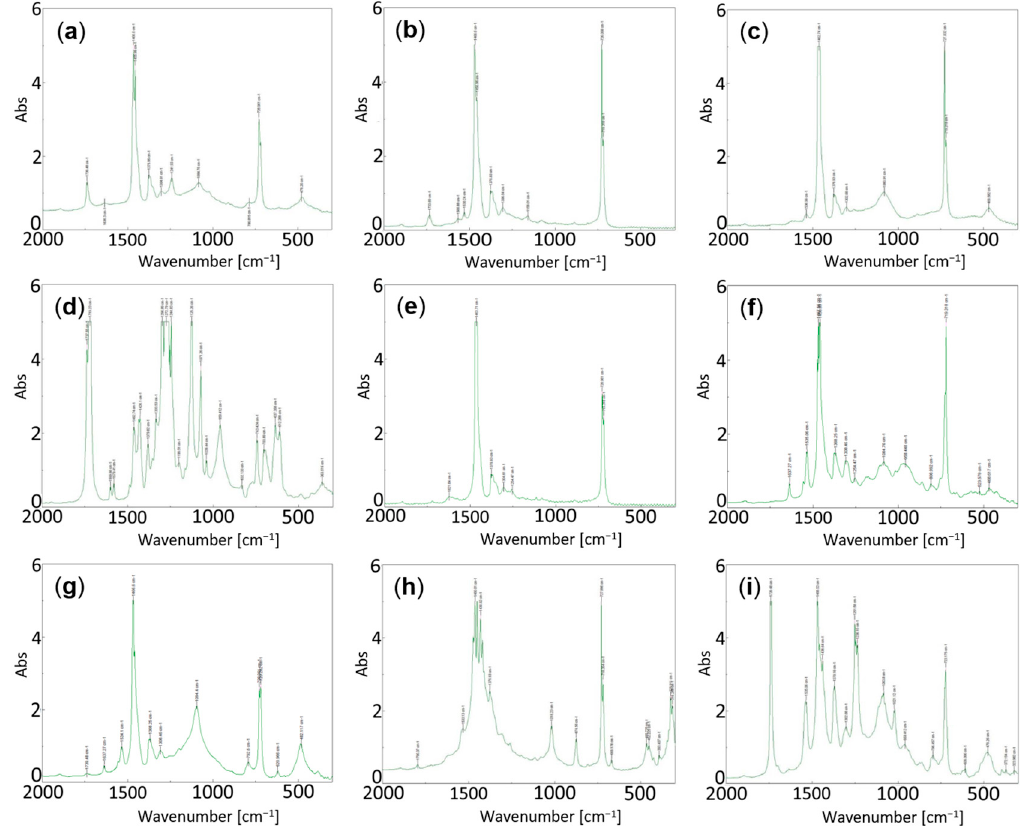
Figure 3. Representative FT-IR spectra of polymeric films: ( a ) P1 (Group 1), ( b ) P5 (Group 2), ( c ) P9 (Group 3), ( d ) P13 (Group 4), ( e ) P20 (Group 5), ( f ) P21 (Group 6), ( g ) P29 (Group 7), ( h ) P45 (Group 8) and ( i ) P49 (Group 9).